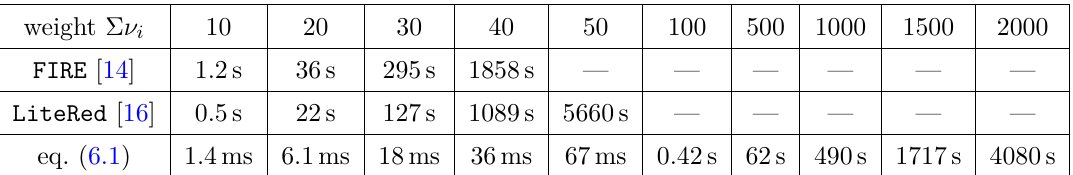
( d ) to m 1 ,m 2 ,m 1 + m 2